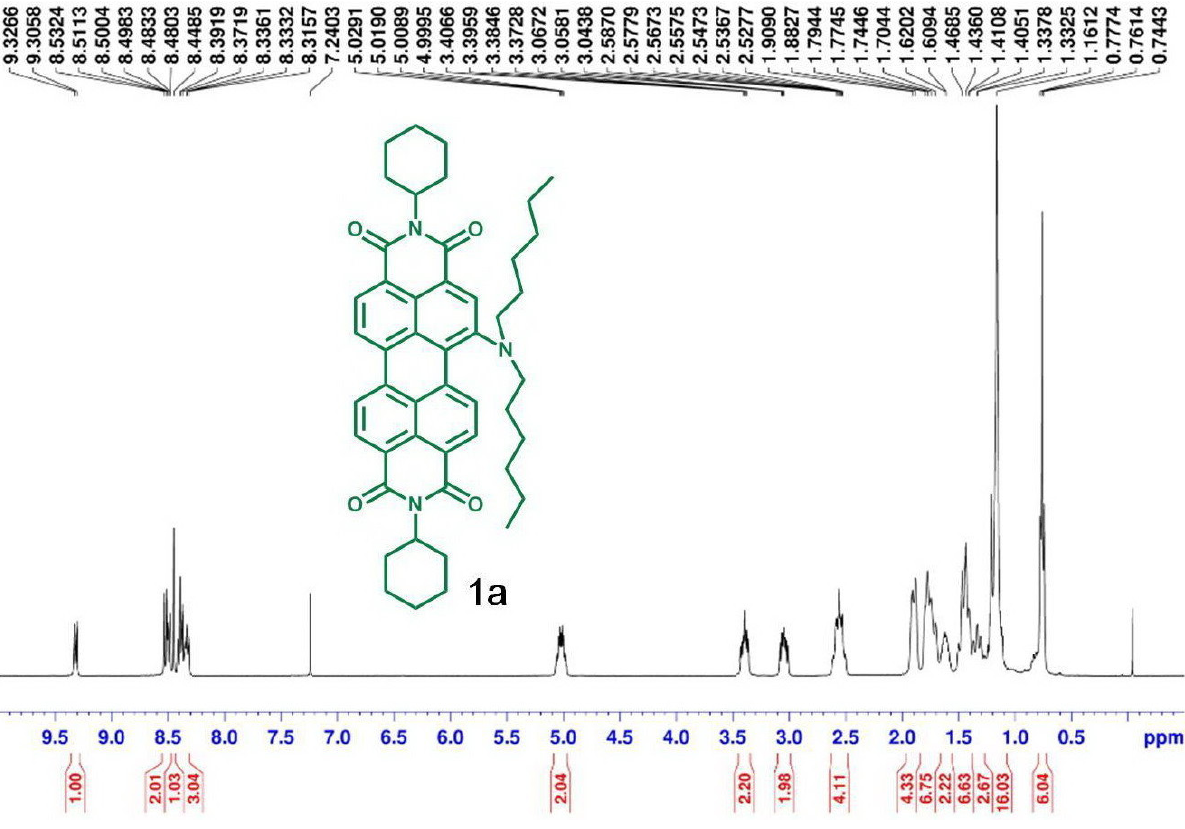
) spectra of 1a 3